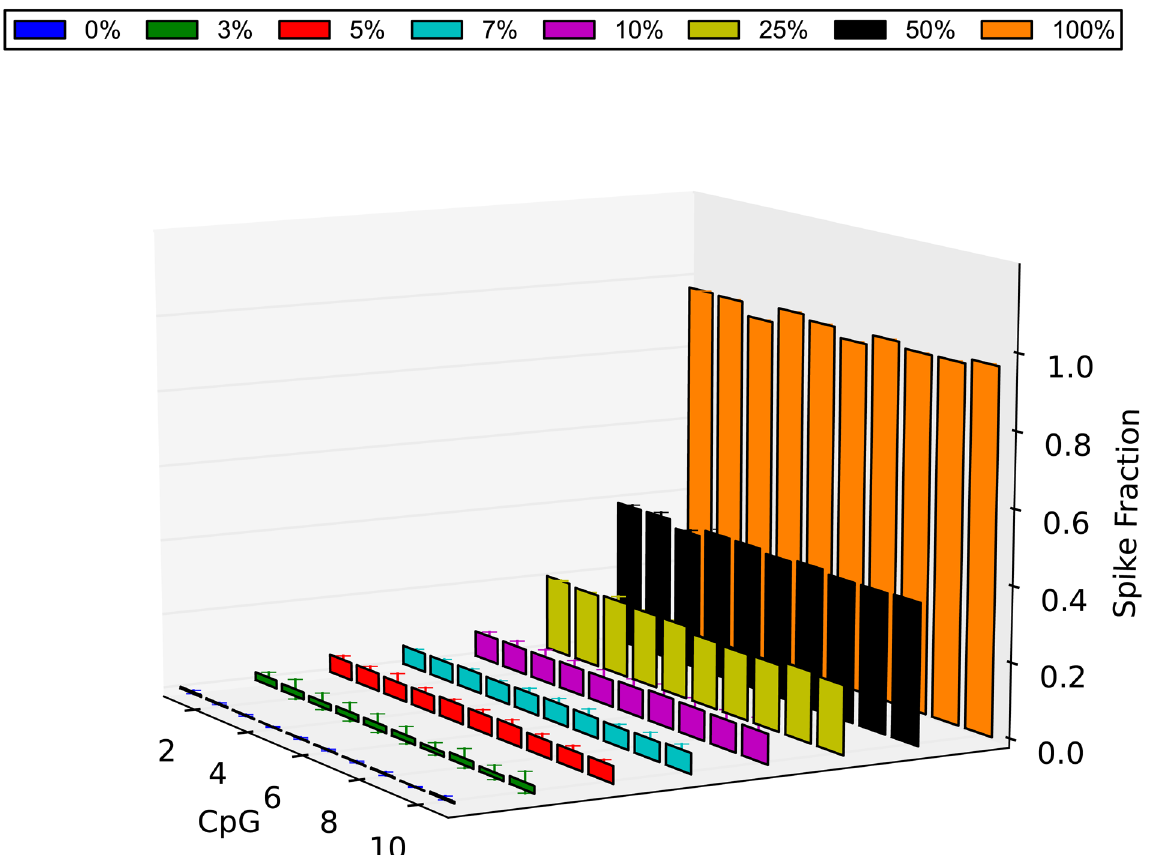
Fig 7. Methylation level of λ -DNA control as determined by NGS. The methylation level of all the CpG sites of the amplified region of the λ -DNA control 2 is plotted for all the spikes. Shown is the average value of each CpG in each spike as was calculated from 3 technical replicates (methylated λ -DNA 0% = blue, 3% = green, 5% = red, 7% = light blue, 10% = purple, 25% = yellow, 50% = black, 100% = orange). In order to calculate statistical significance of the methylation level of each spike, we created a dataset of average performance for each spike group and we compared these average performance datasets with the 100% unmethylated average performance set using a t-test. It was demonstrated that all the small-percentage spikes showed significantly higher methylation levels than the 0% methylated group [3% (P = 2.704e-11), 5% (P = 1.685e-21), 7% (P = 1.181e-23), 10% (P = 2.991e-19)]. Errors bars = SD